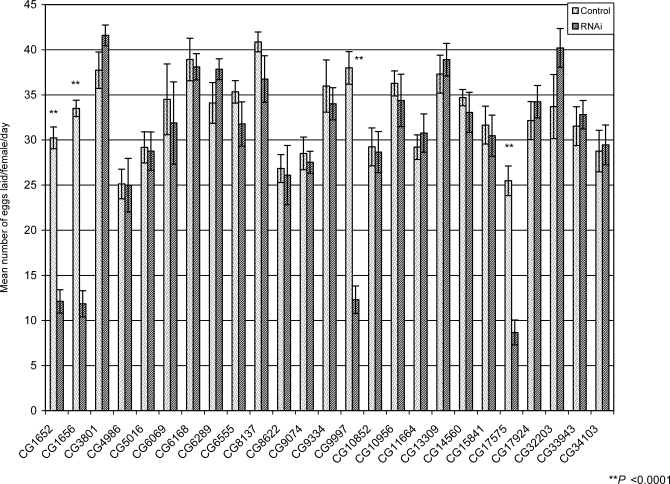
The Effect of Knockdown of Different Acps on Egg Laying by Mated FemalesShown here is the number (mean ± SE) of eggs laid per day by the mates of knockdown males (RNAi) or control males over a period of 10 days. Egg laying response by the mates of most knockdown males was not significantly different from their control mates (p > 0.5). However, mates of CG1652/CG1656, CG17575, or CG9997 laid significantly fewer eggs compared to their controls (p < 0.0001). Number of females ranged from 15–45 depending on the Acp analyzed.